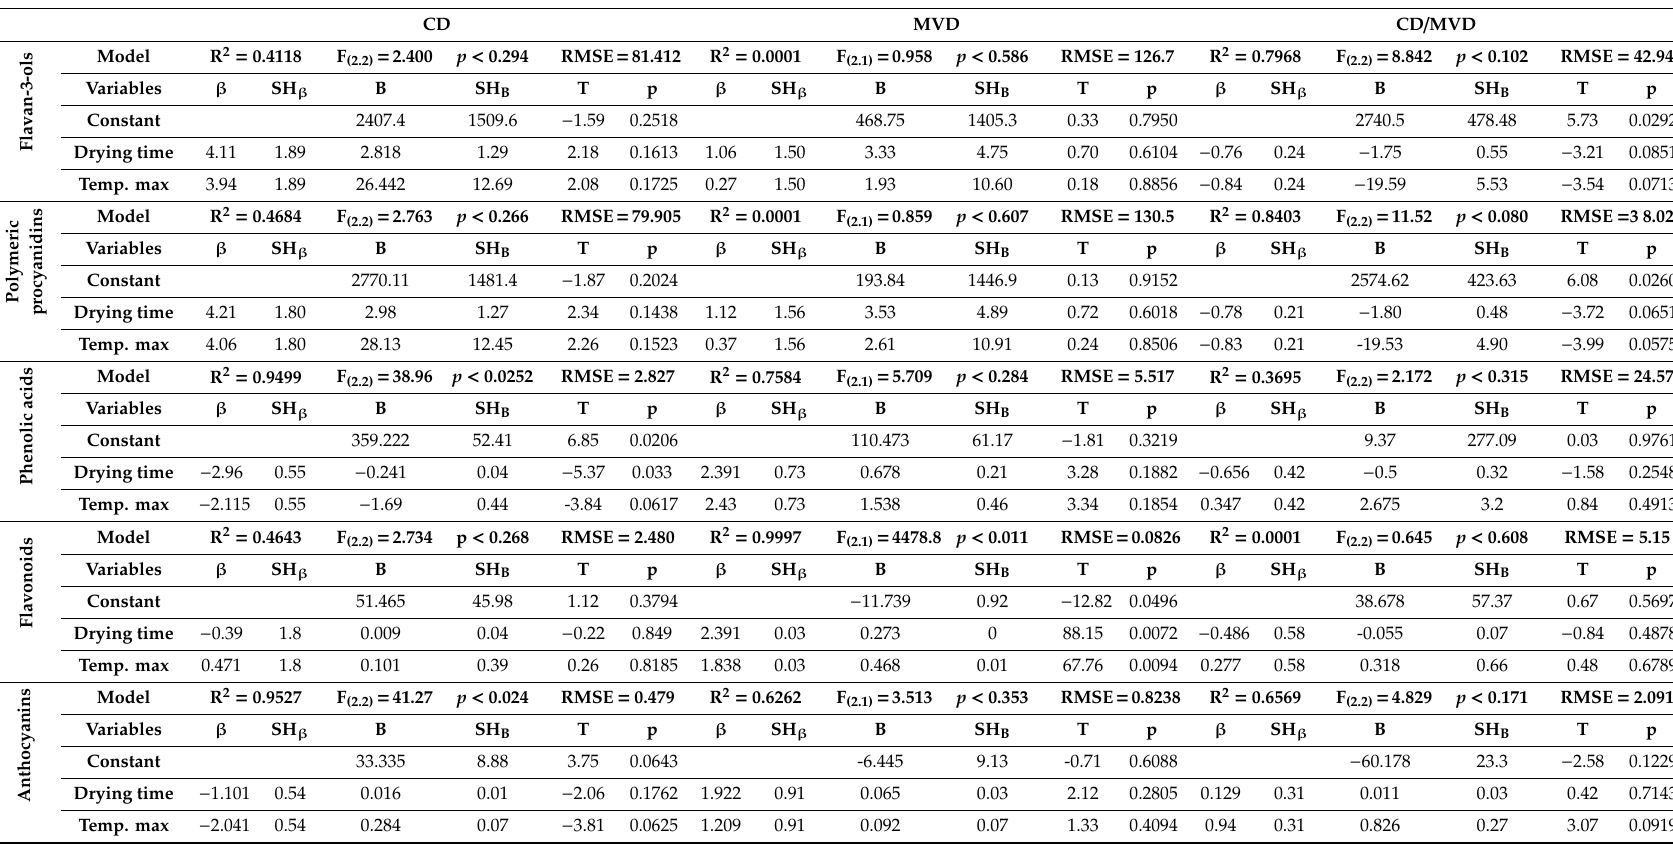
Table 4. Multiple linear regression analysis results for polyphenolic compounds and antioxidant capacity of plum pomace